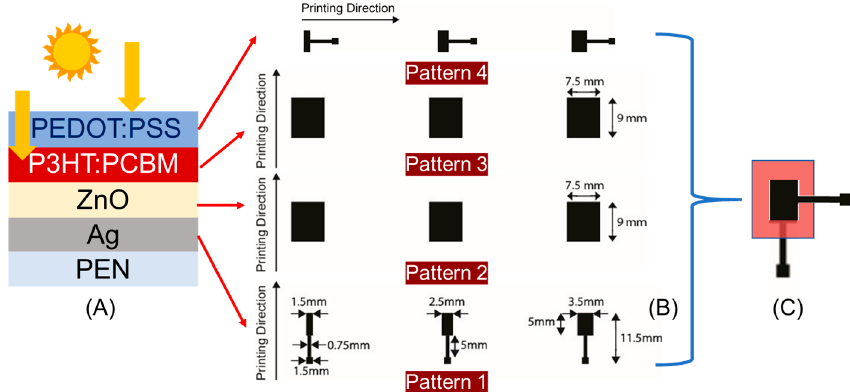
Figure 1. Image showing a ( A ) conventional OPV device architecture, ( B ) an overview of the designed digital patterns 1–4 with bottom Ag and top PEDOT:PSS electrode layers with different sizes and constant size of the electron transport layer (ETL) and bulk heterojunction (BHJ) layers, and ( C ) a top view of the intended OPV device.